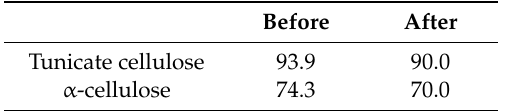
Table 3. The variations of CrI of tunicate and α -celluloses before and after the acid hydrolysis. Before